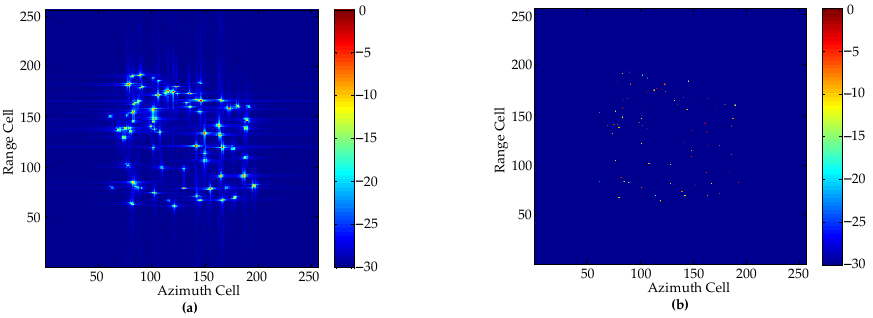
Figure 4. An example of training data: ( a ) input image; ( b ) annotation image.